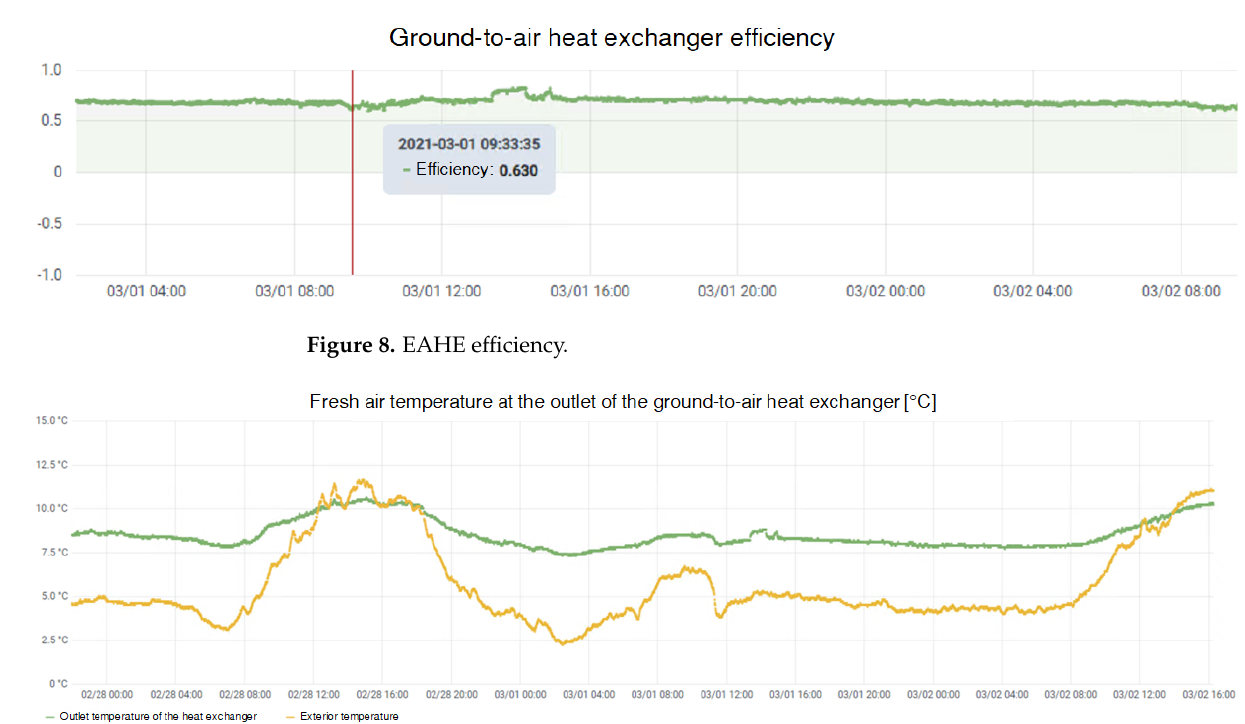
Figure 9. Outdoor temperature and air outlet temperature from the EAHE.